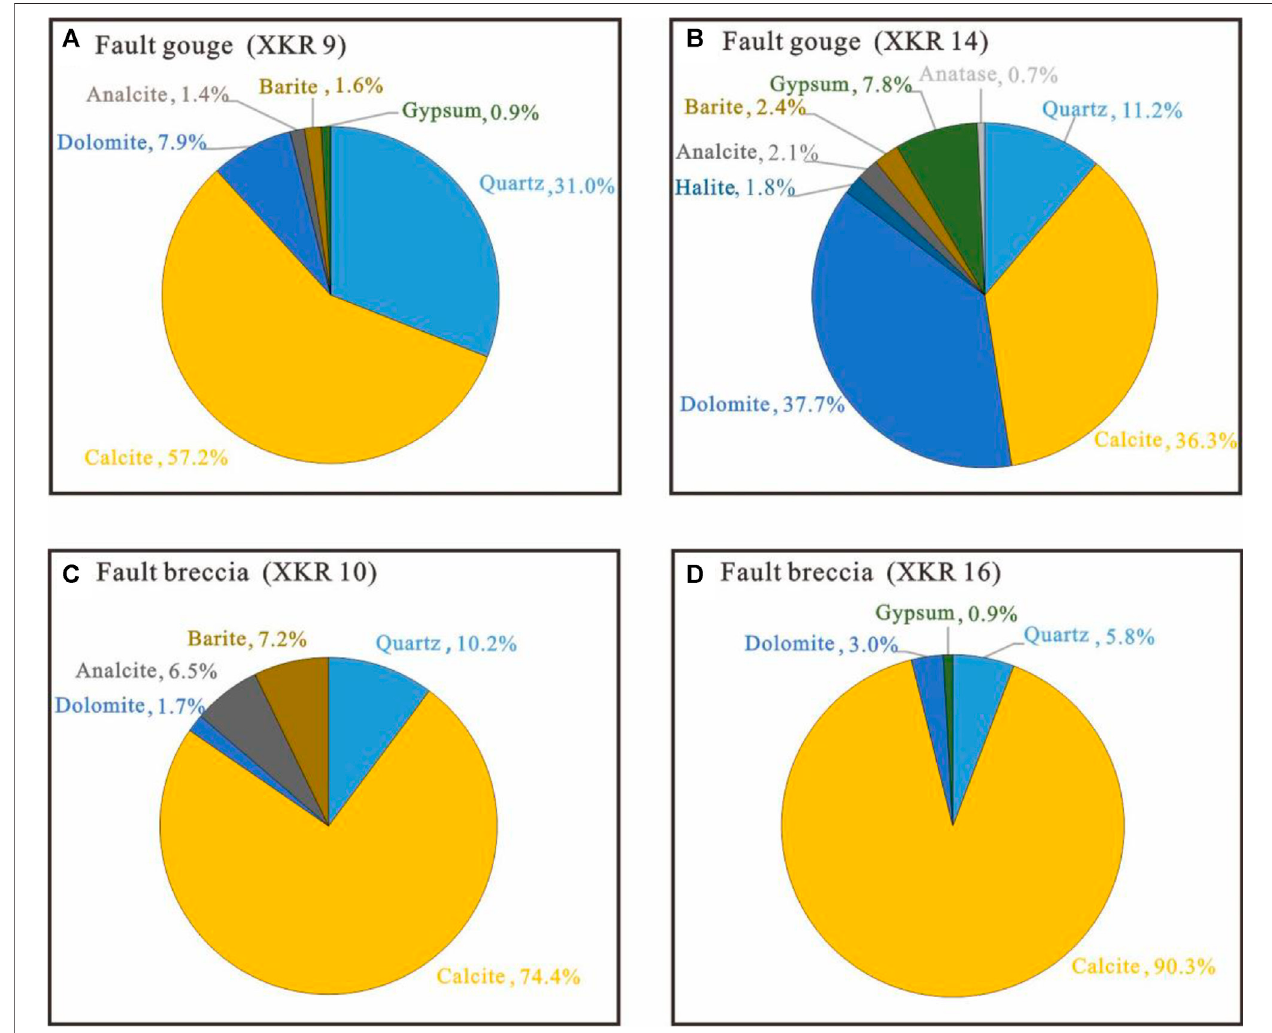
FIGURE 7 | Mineral composition of fault gouge and breccia zone. All four samples are located in the fault core, where XKR 9 and XKR 14 are fault gouges and the rest are fault breccias. (A,B) are mainly composed of calcite, dolomite and quartz, and contain a variety of hydrothermal minerals. (C,D) fault breccia has few mineral compositions, mainly calcite, but also contains a small part of hydrothermal